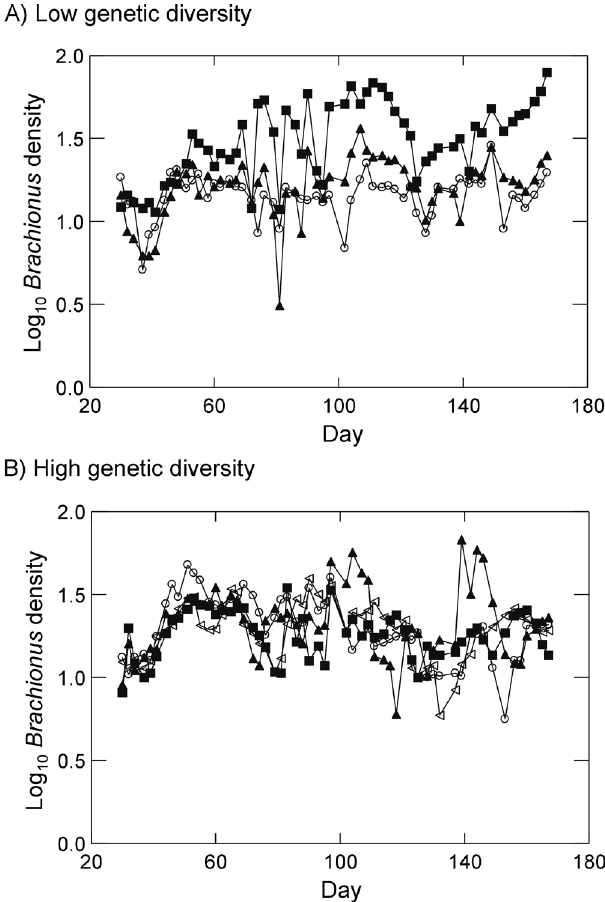
Figure 2. Brachionus dynamics in the presence of ( A ) low initial prey genetic diversity (prey populations started with a single strain of Synura ) or ( B ) high initial prey genetic diversity (prey population started with five strains of Synura ). Dynamics for each replicate are shown separately (different symbols). Original units in numbers of individuals per